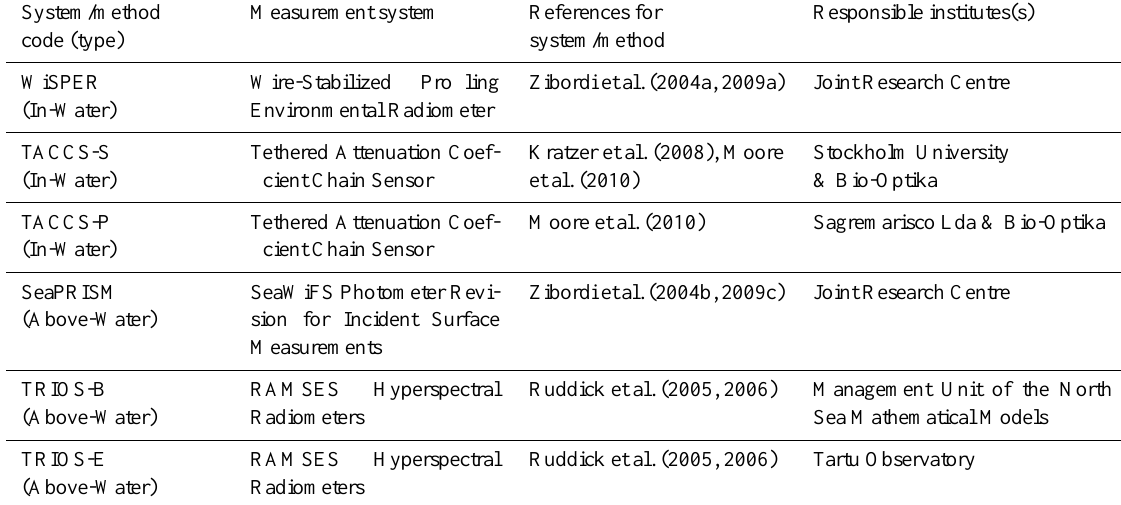
Table 1. Summary of codes assigned to measurement systems/methods together with relevant references and responsible